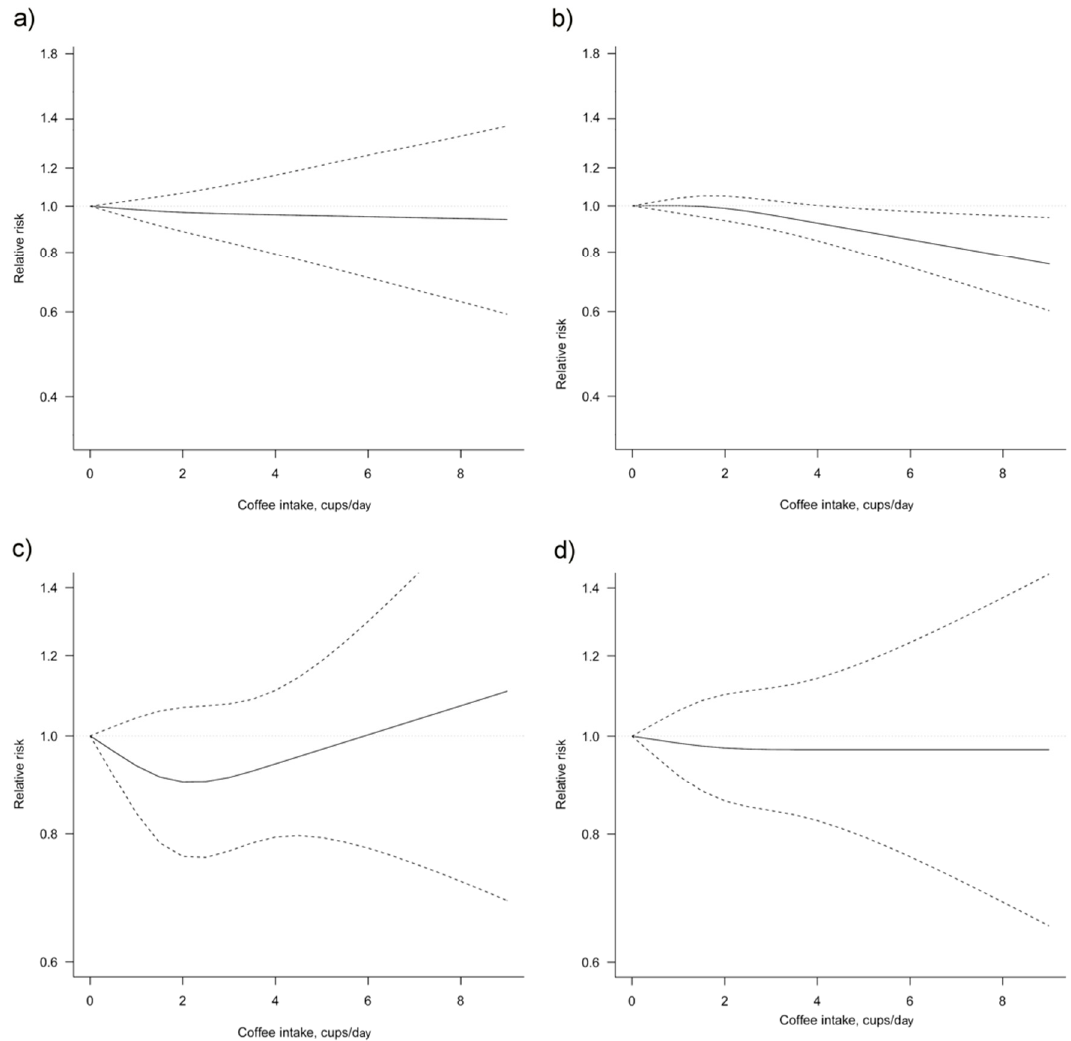
Figure 3. Dose-response association between coffee consumption and breast cancer risk ( a ) non-linear, total analysis; ( b ) non-linear, postmenopausal; ( c ) non-linear, receptor status ER-/PR-; ( d ) non-linear, BMI ≥ 25 kg/m 2 . Solid lines represent relative risk, dashed lines represent 95% confidence intervals.